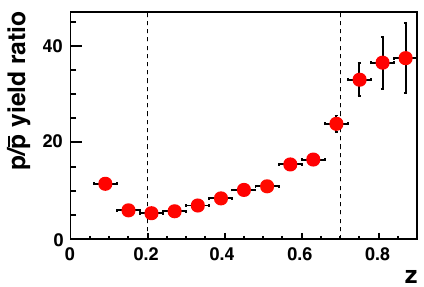
Figure 18 . Ratio of raw proton to antiproton yields at HERMES as a function of z . The bin boundaries for the semi-inclusive DIS range are marked by dashed lines. The ratio exhibits a clear rise towards very low z , which might indicate the onset of significant target-fragmentation contributions, excluded in the data sample used by the minimum- z requirement of